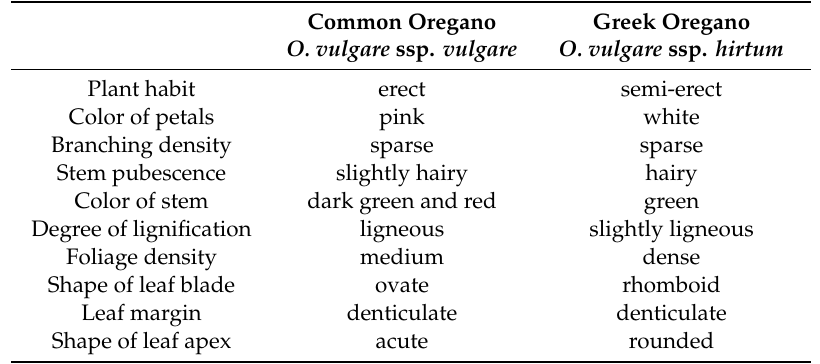
Table 2. Morphological traits of investigated plants.